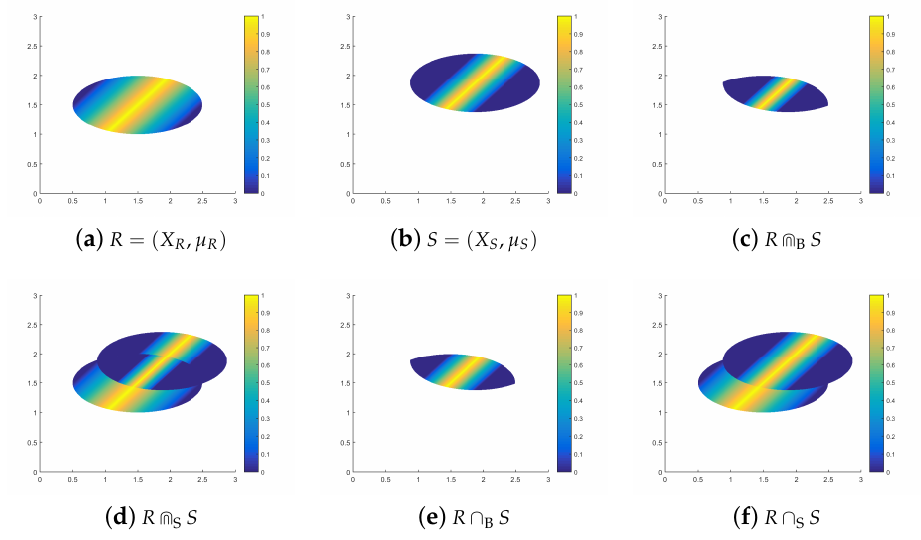
Figure 9. Intersections of functional partial fuzzy